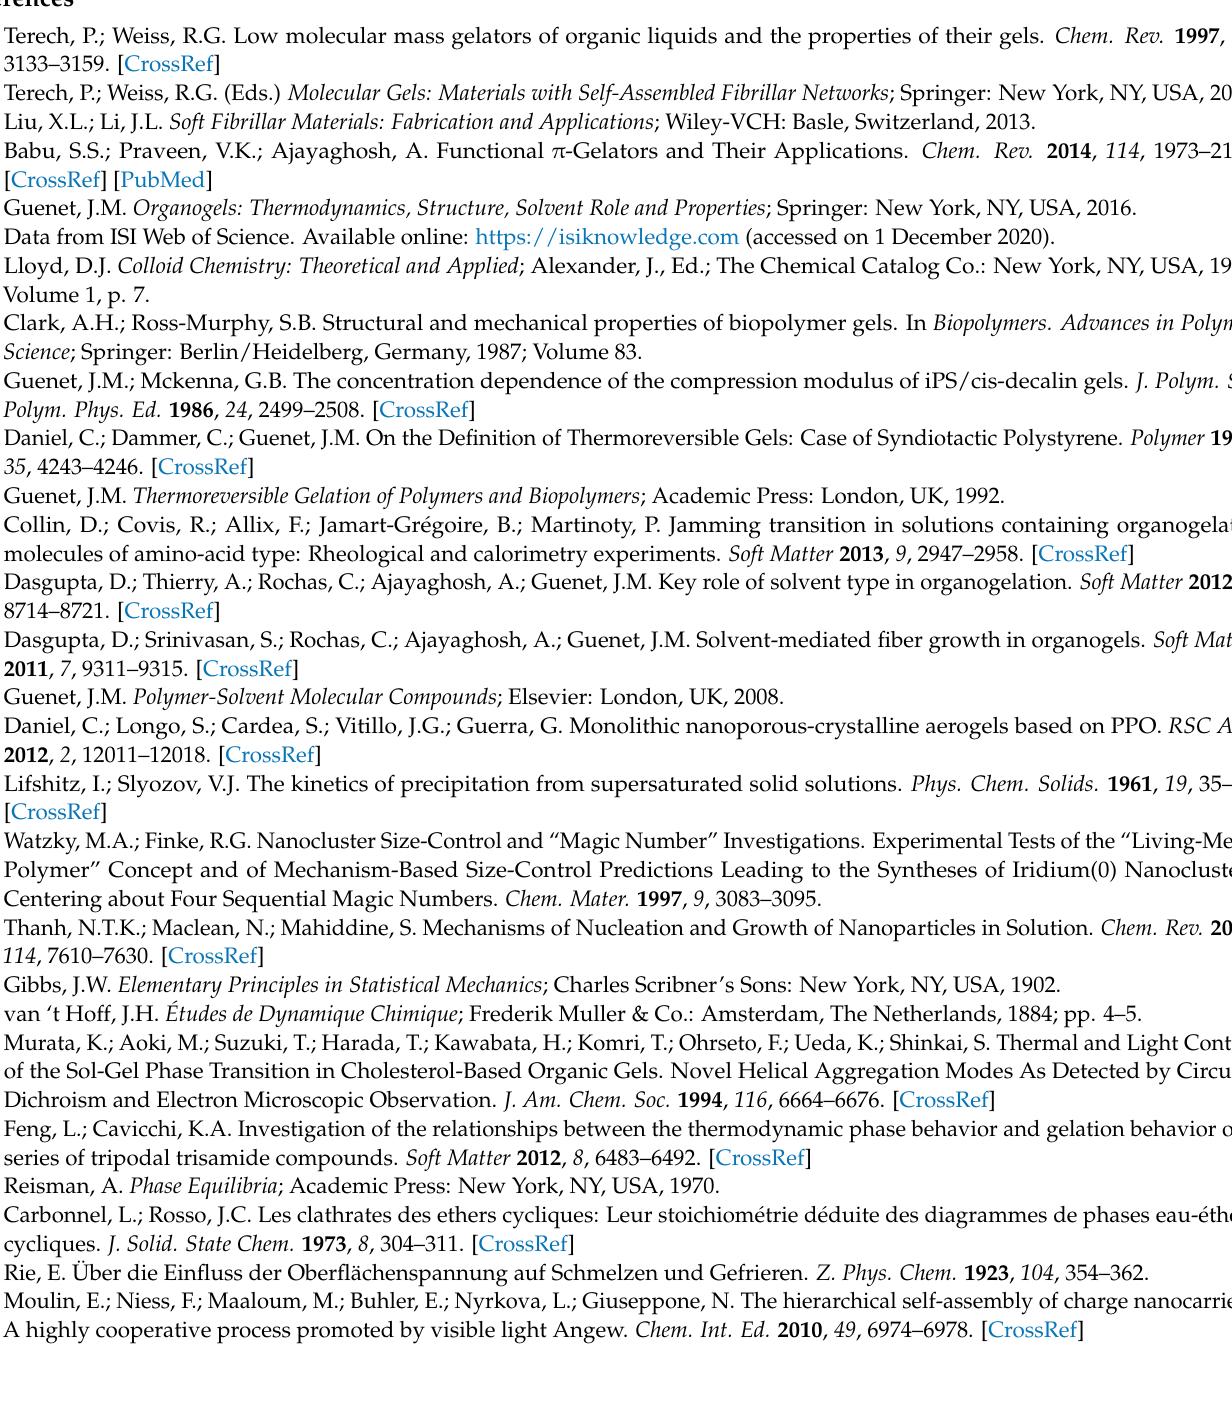
Figure A5. Peptide protected by a benzyloxycarbonyl group at its N-terminal, and by a hydrazine naphthalimide at the C-terminal [12].